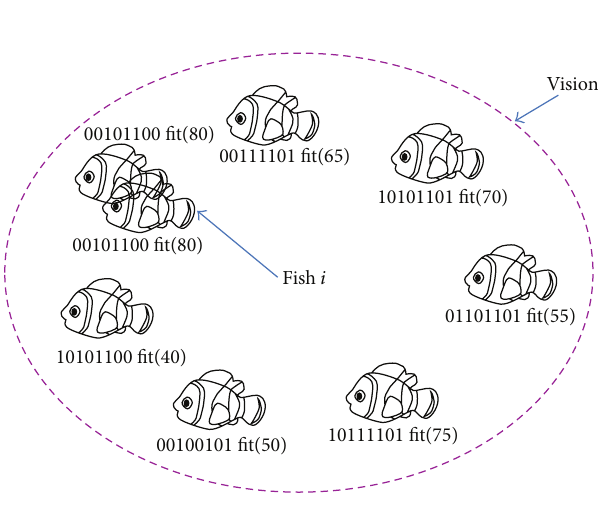
Figure 3: Follow step of